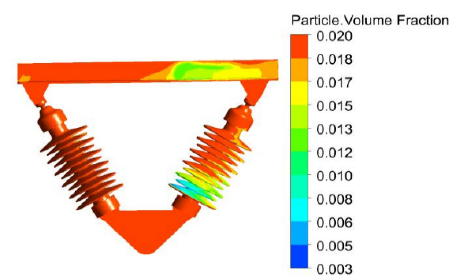
Figure 32. Distribution map of contamination on the surface of insulators.